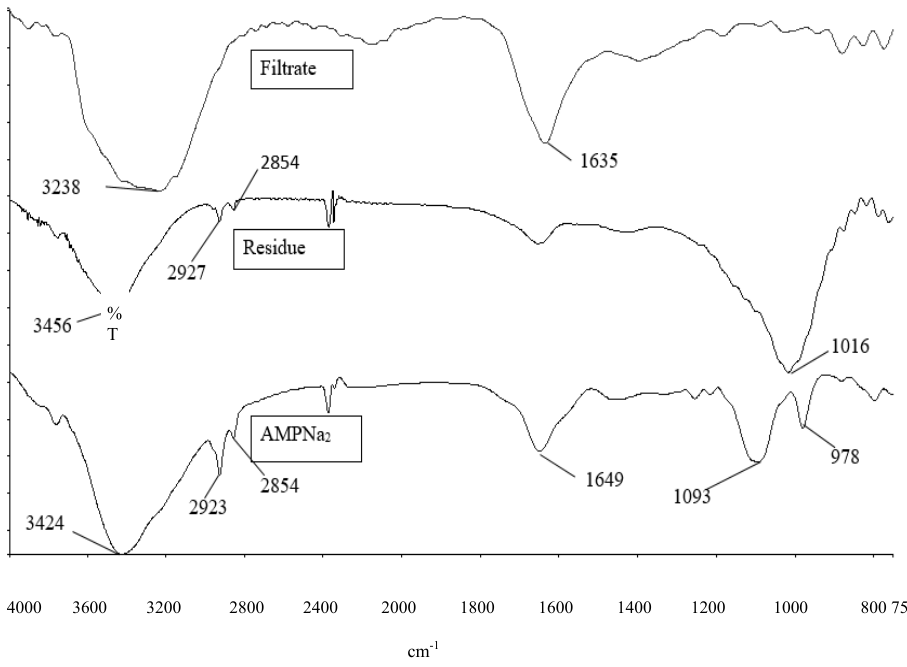
in the presence of 2